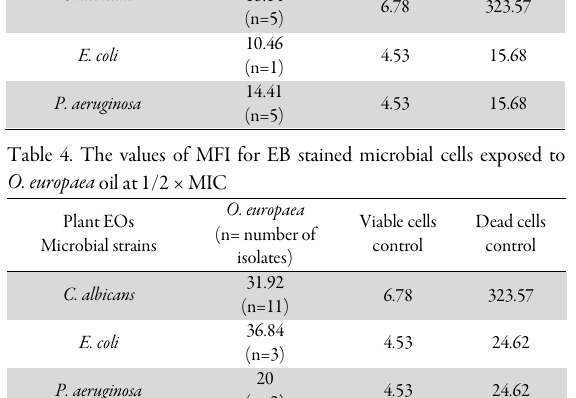
Table 1. MIC values (mg/ml) of the tested fatty oil Microbial strains